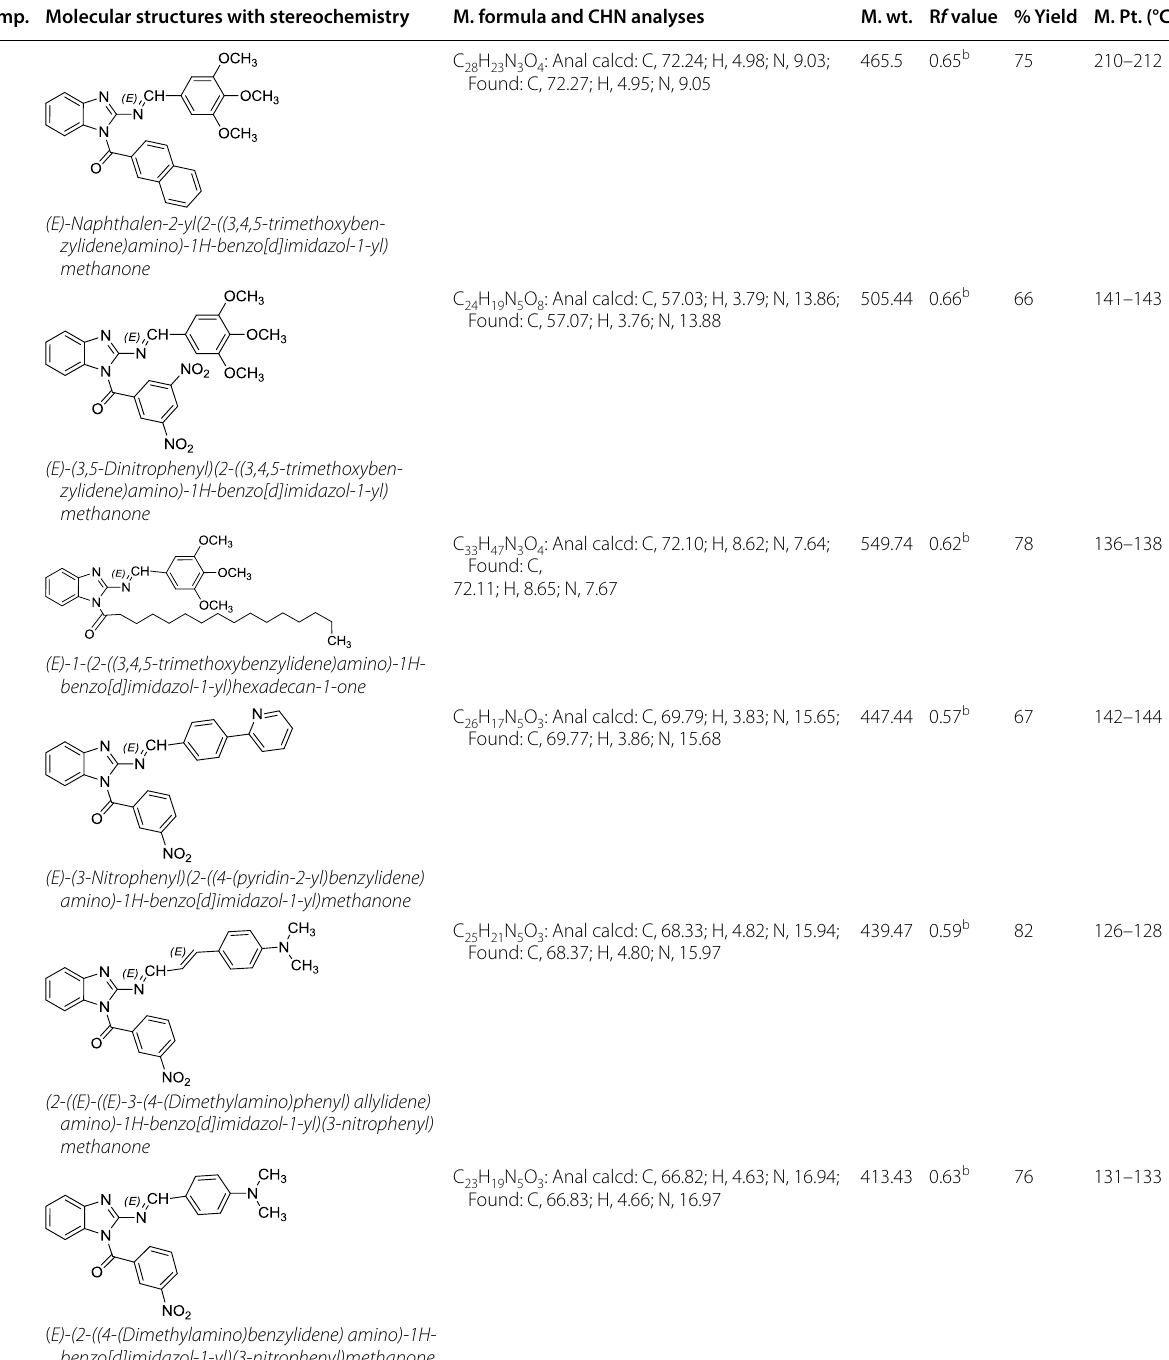
M. formula and CHN